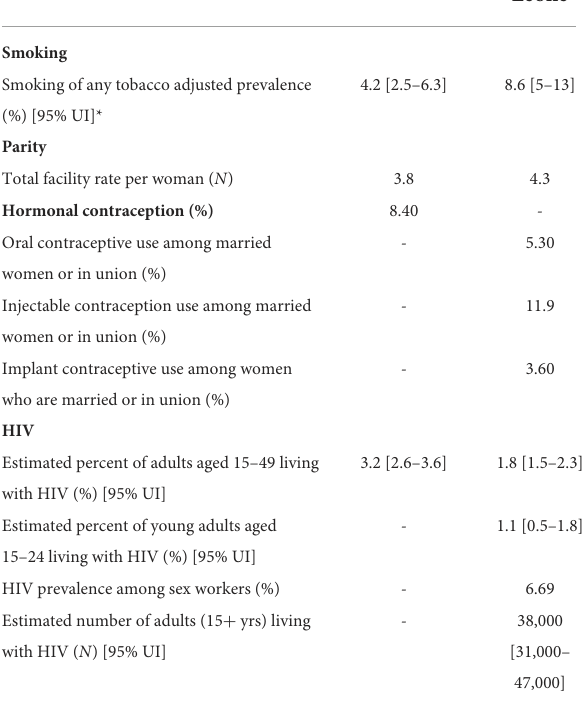
TABLE 2 Cervical cancer-associated factors among women in Rwanda and Sierra Leone.